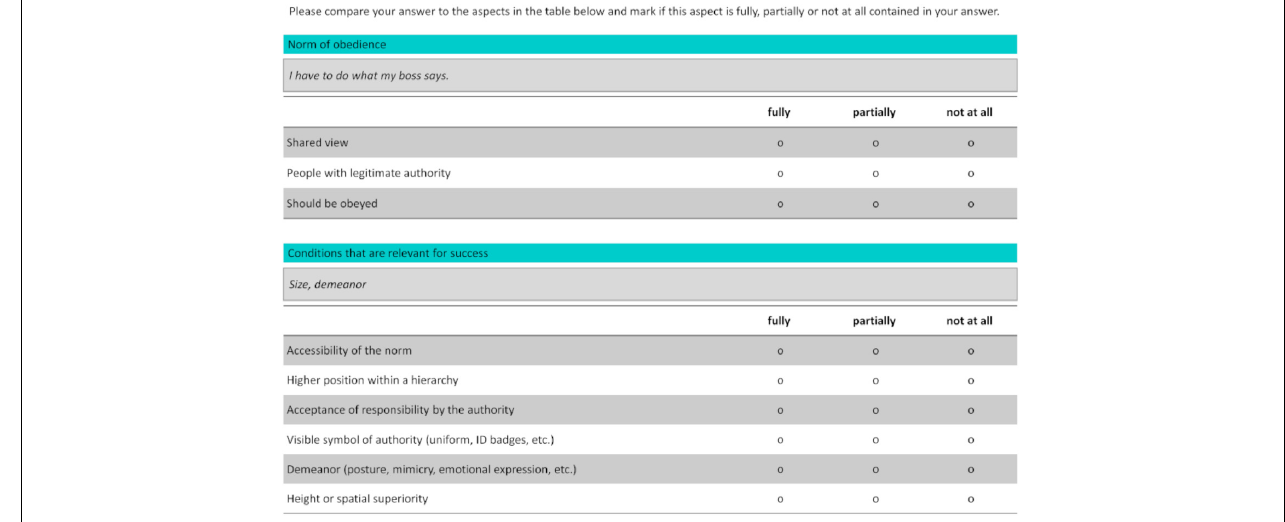
FIGURE 1 | Feedback mask as used during the learning phase of the testing conditions (translated from German).